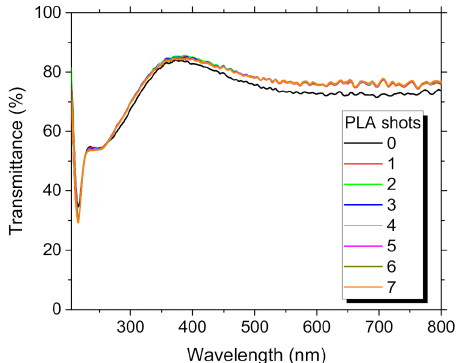
Figure 11. Transmittance spectra Lu 2 O 3 :Eu thin film, dependence on the number of PLA shots.